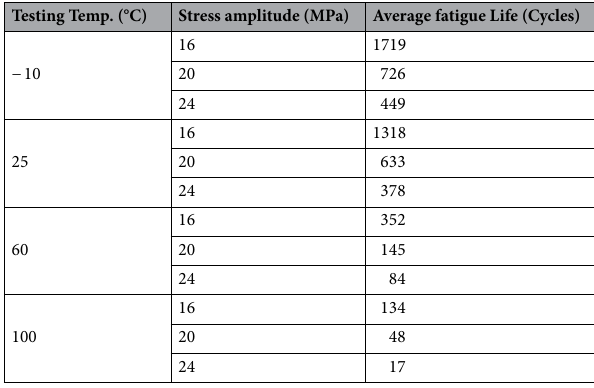
Table 2. The average fatigue life at different experimental conditions.